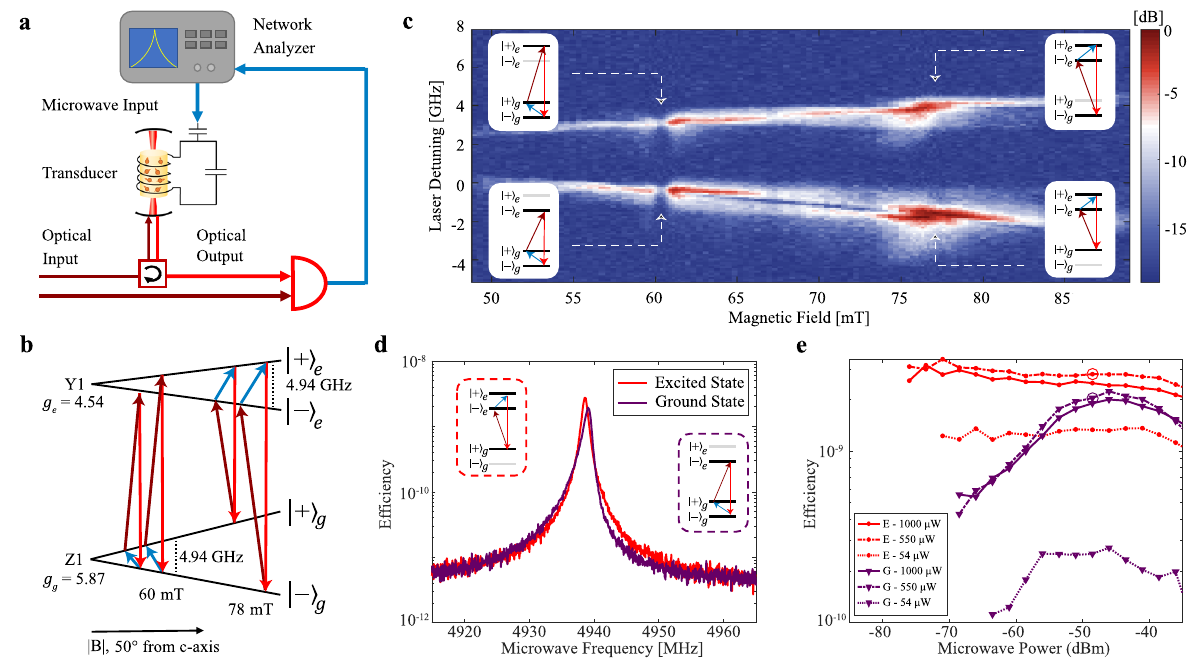
Fig. 2 | CW M2O transduction ef fi ciency with heterodyne detection. a CW het- erodynedetectionset-upwheretheupconvertedopticaltone,generatedbymixing an optical pump and the microwave tone in the transducer, was mixed with an optical local oscillator on a photodetector. The microwave beat note signal was then detected on a network analyzer. b The Er 3+ :YVO 4 level structure showing all four con fi gurations for generating transduction signals including two using the ground state spin at B~60 mT and two using the excited state spinatB~78 mT. The g-factorsofthe ground and excited state are shown for the transduction magnetic fi eldangleof50degreesfromthec-axis. c Normalizedheterodynespectrumwhere theappliedbiasmagnetic fi eldandthepumplaserfrequencywereswept.Thefour